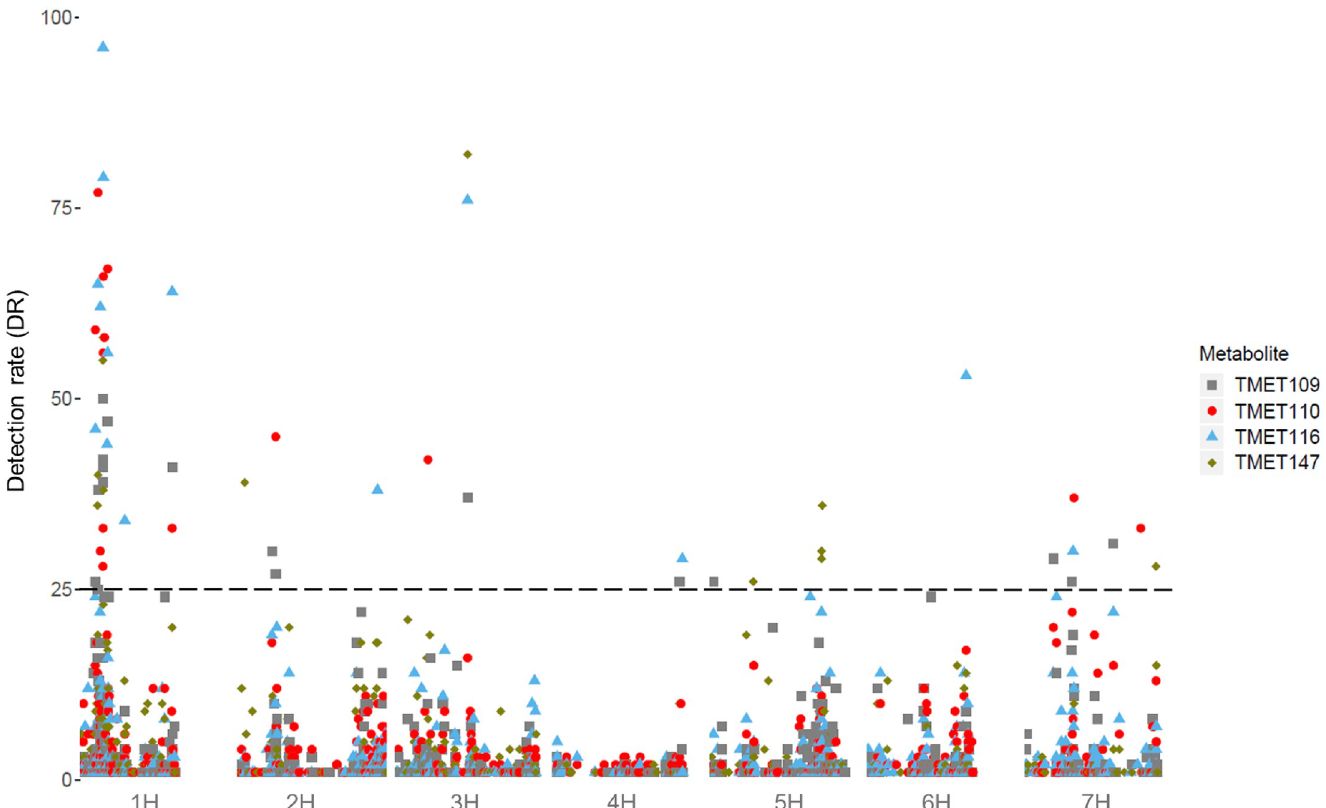
Fig 2. Manhattan plot of all metabolites of the first sampling date. All metabolites showed significant marker-metabolite associations on chromosome 1H. The different point shapes and point colours differentiate the metabolites and the associated SNPs. The x-axis shows the chromosomes with SNP ordering based on the Morex Reference Sequence 1.0 [49], the detection rate (DR) is given on the y-axis. The dashed line indicates the threshold of DR > 25, which was used as significance threshold.